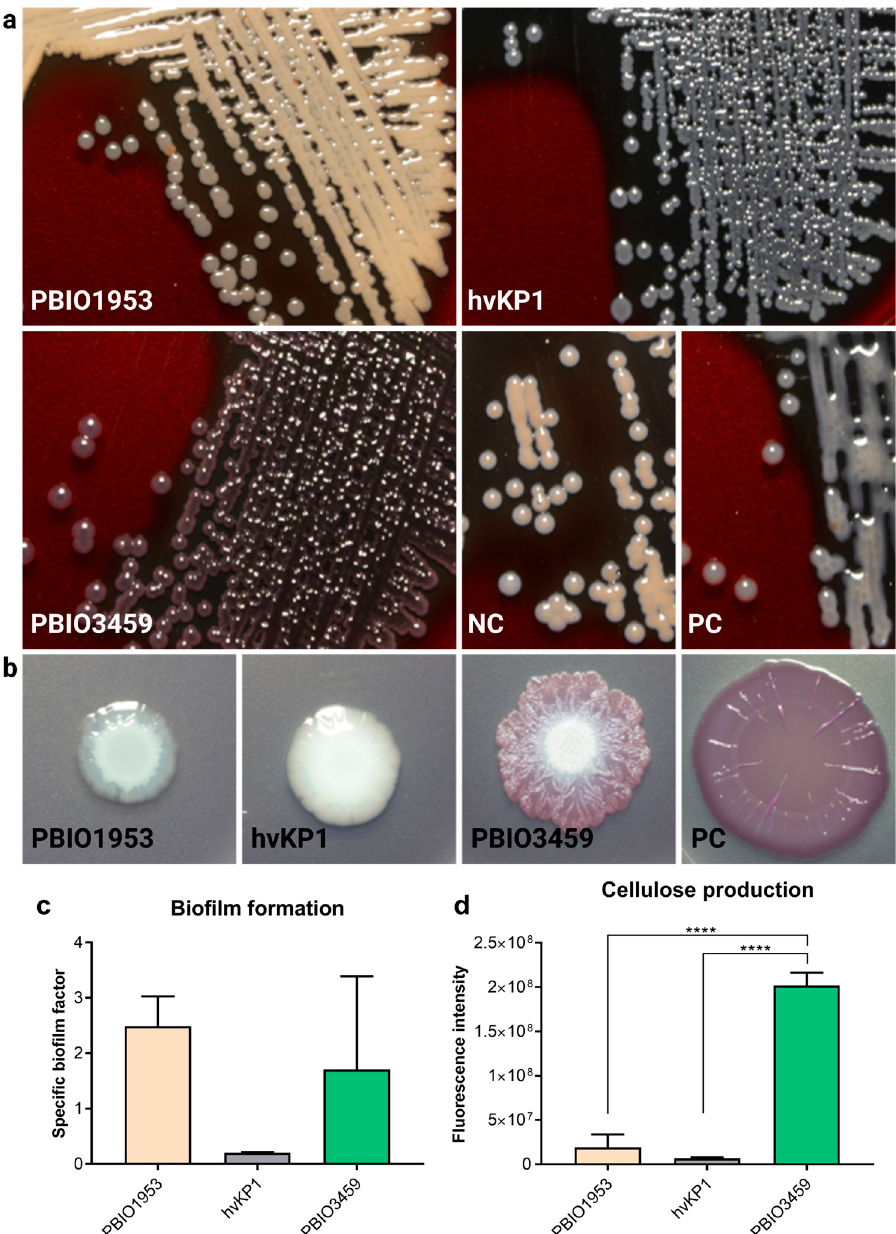
Figure 2. Representative images of phenotypic assays and phenotypic assays related to biofilm forming abilities and pathogenesis. ( a ) Production of exopolysaccharides. Isolates were plated on BHI agar and incubated for 24 h at 37 ◦ C. PBIO1953 was tested negative for the production of exopolysac- charides, hvKP1 was tested positive and the result for PBIO3459 could not be determined clearly. The negative control (NC) was tested negative and the positive control (PC) positive. ( b ) Cellulose and curli fimbriae production was investigated in long-term colonies. PBIO1953 and hvKP1 produced neither structures while the phenotype of PBIO3459 differed from usual (control) long-term colonies. The PC produced both curli fimbriae and cellulose. ( c ) Adherence ability given as specific biofilm factor. Results are given as mean values with standard deviation. ( d ) Cellulose production of the respective isolates. Results are expressed as mean fluorescence intensities with standard deviation ( n = 3). Statistical significance was tested with one-way ANOVA (with Dunnett’s multiple comparison post hoc test); **** p <